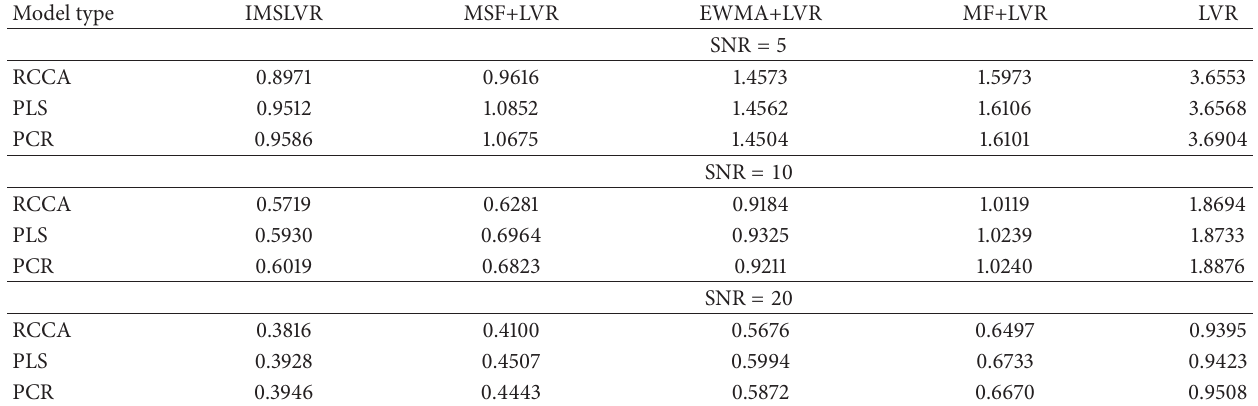
Table 1: Comparison of the Monte Carlo MSEs for the various modeling techniques in example 1.